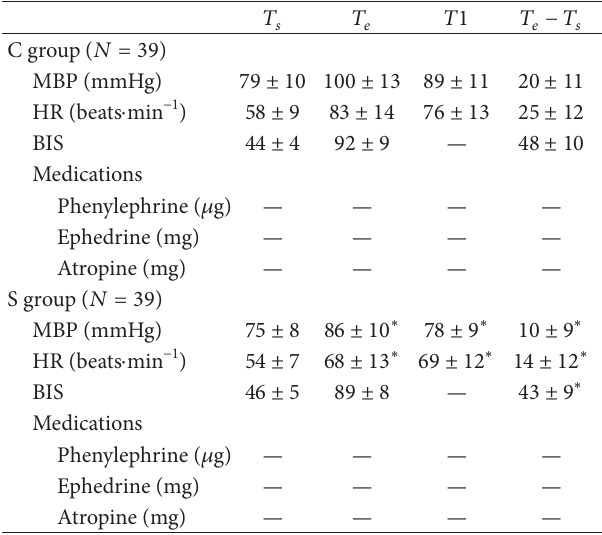
Table 2: Haemodynamic parameters and bispectral